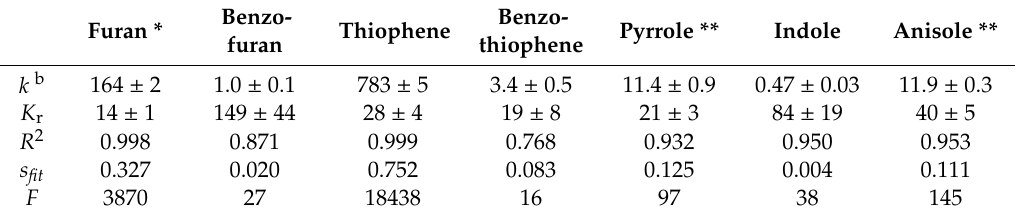
Table 4. Rate constants, k , and relative sorption equilibrium constants, K r , of the HBEA-D-AT catalytic reactions. Shown also are the fits’ statistical figures of merit a .